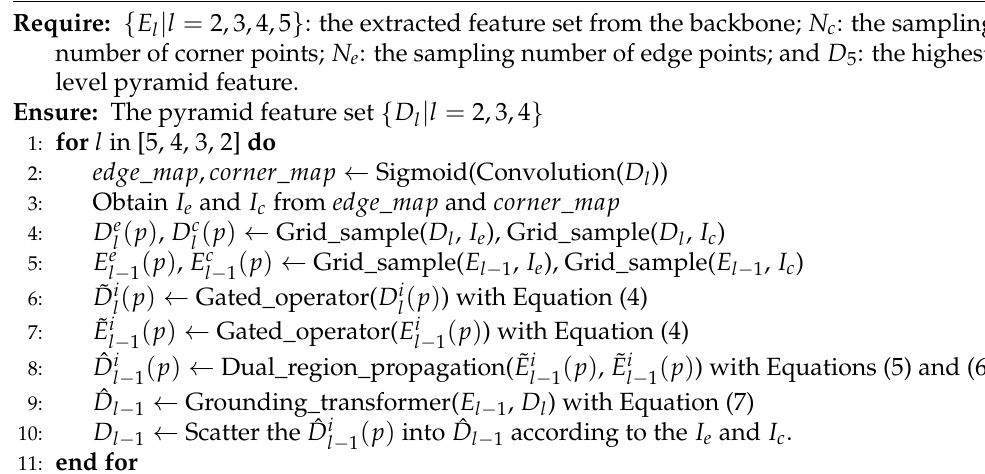
Algorithm 1 The top-down procedure in SGFANet.